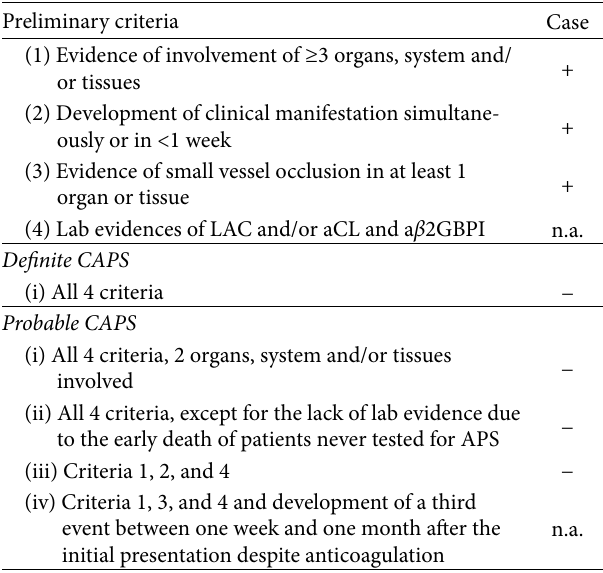
Table 6: Possible therapeutic